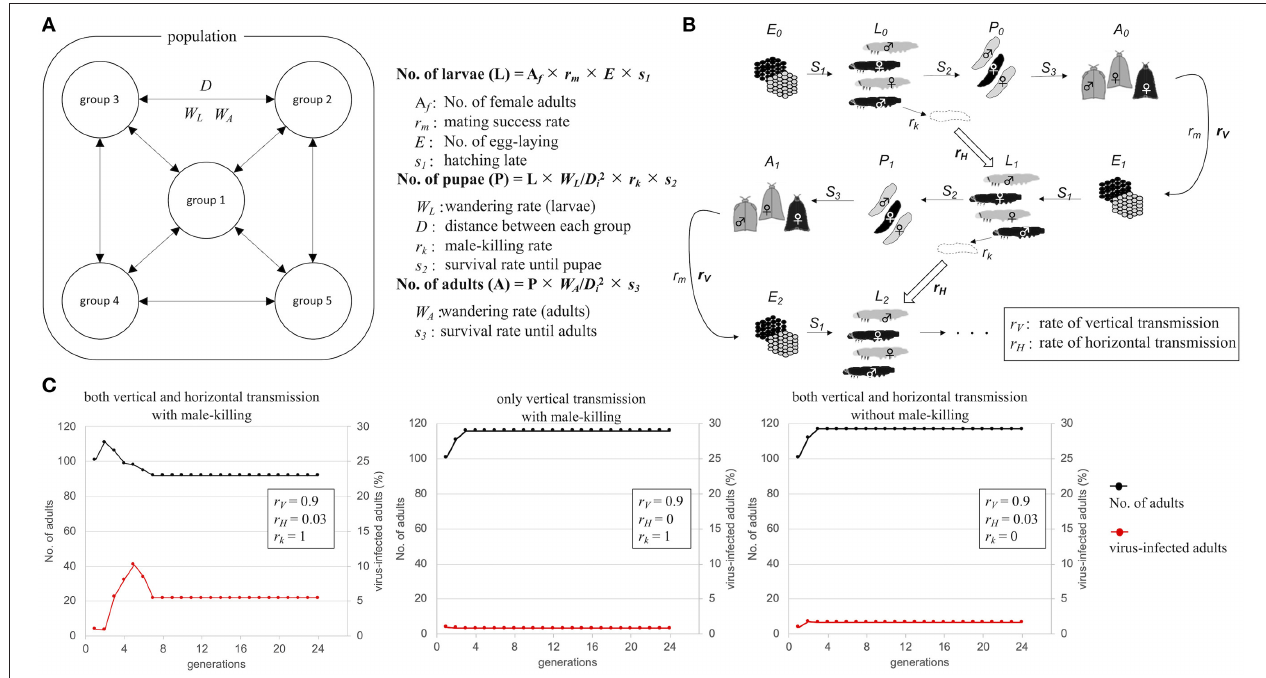
FIGURE 4 | Schematic model of Osugoroshi virus (OGV) infection in a Homona magnanima population. (A) Population setting for mathematical modeling. An H. magnanima population is composed of five separated groups. Some parts of larvae ( W L ) and adult ( W A ) moths wander across each group according to the relative distance to another group ( D ). (B) Infection model of OGV and through H. magnanima populations. During the stages, OGV-infected male larvae (black) go to die ( r k ) and spread virus progenies, and the larvae in the next generation uptake viruses with a certain probability ( r H ). OGVs are also transmitted to the next generation from virus-infected females ( r V ). (C) Population simulation of H. magnanima after OGV-contamination with various situations. The populations start with 100 naïve individuals and 1 OGV-infected female (black lines). OGV-infected moths (red lines) are maintained throught generations by vertical and/or horizontal transfer.